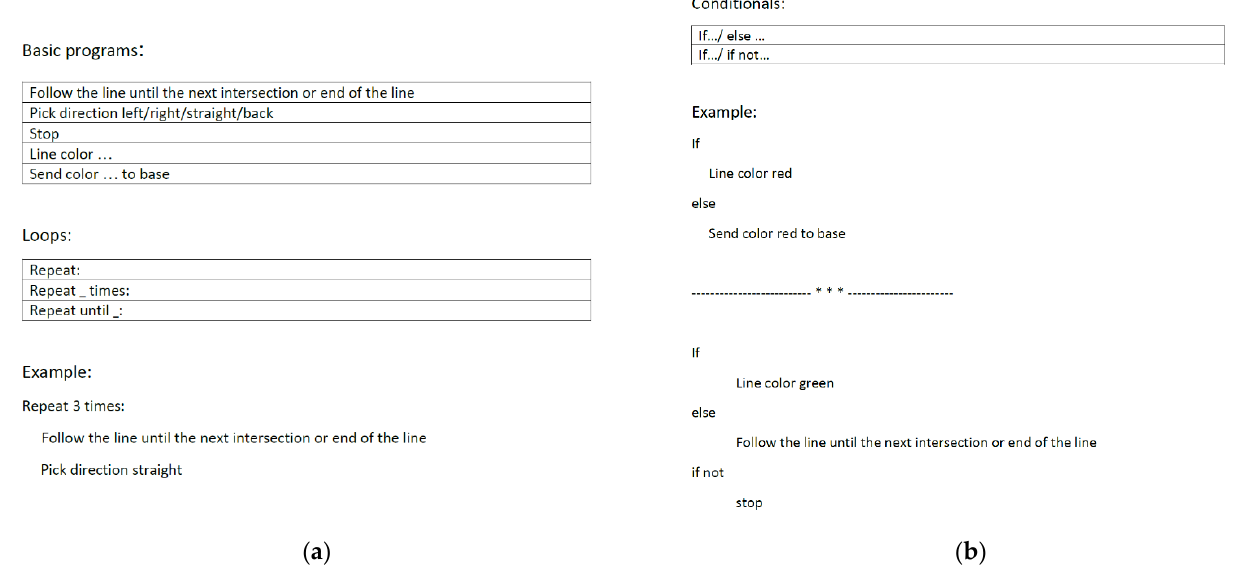
Figure 2. Instructions for students to program the spatial robot: ( a ) basic programs and loops, with an example; and ( b ) conditionals with examples.